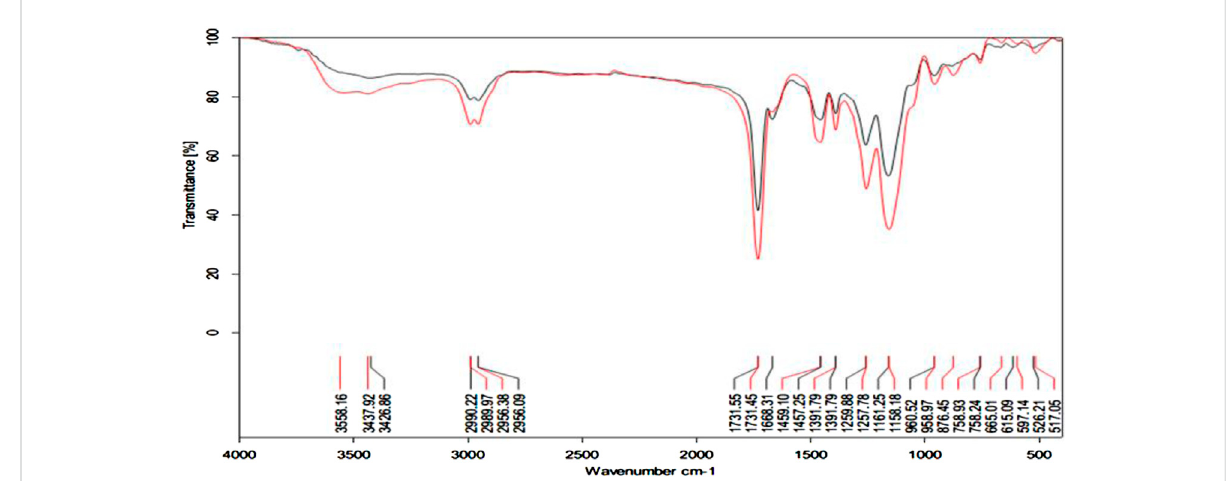
FIGURE 2 FT-IR spectra for the unloaded MIP (black line), and the oxycodone loaded MIP (red line).